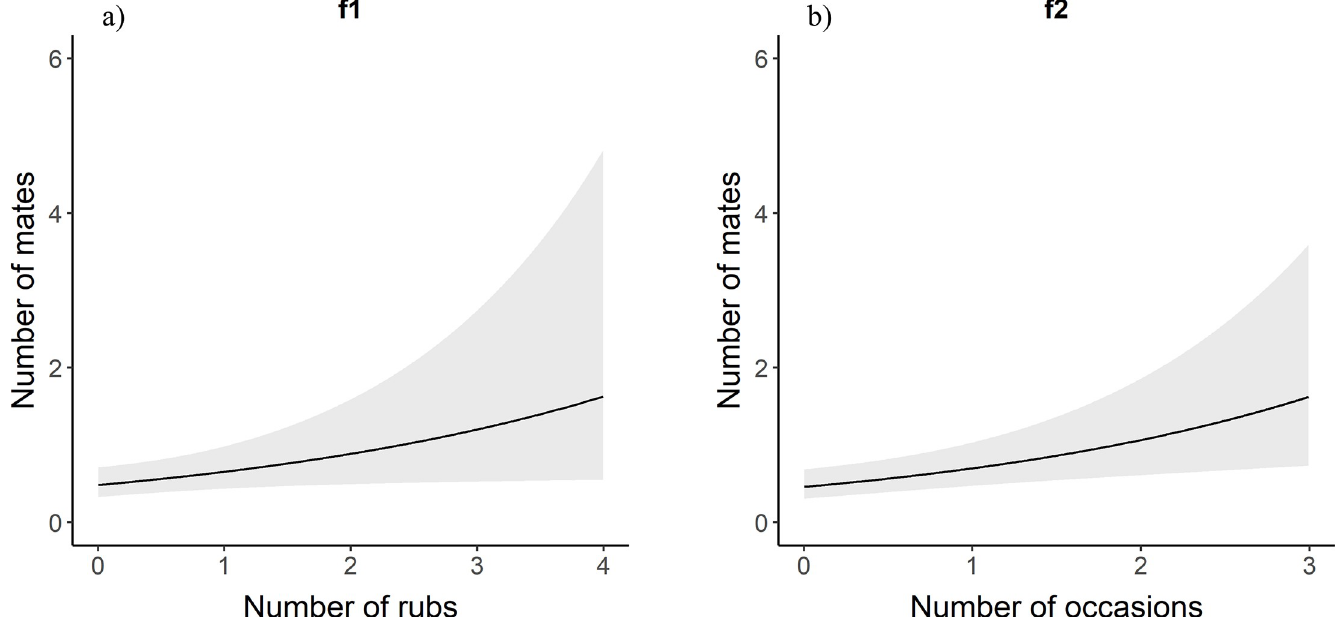
Fig 5. f1 and f2. Poisson regression response curves showing the relationship between the number of mates a female brown bear had and the number of rubbed objects (a) at which and sampling occasions (b) during which it was detected. Confidence intervals are in grey. Data are from southwestern Alberta 2011–2014.